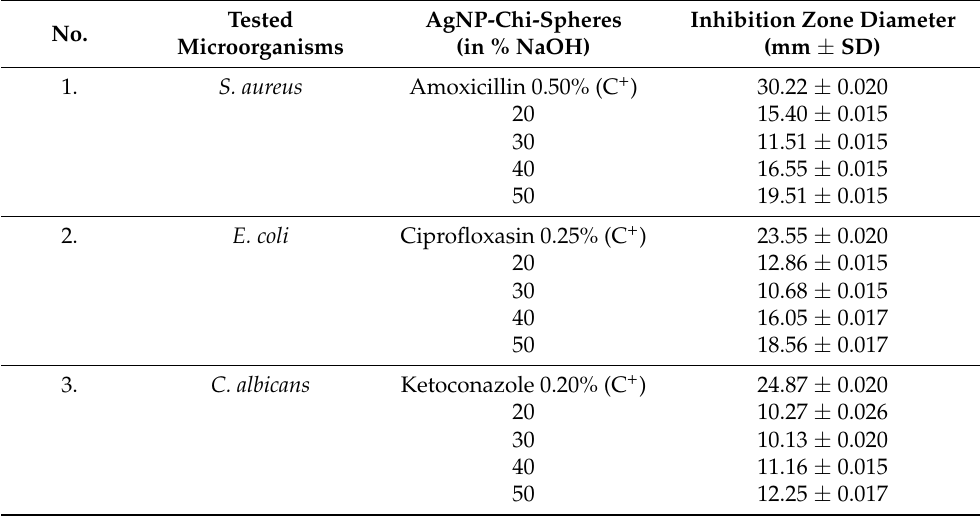
Table 5. Antimicrobial activity of AgNP-chi-spheres after 24 h of incubation time. The inhibition zone diameter was performed in